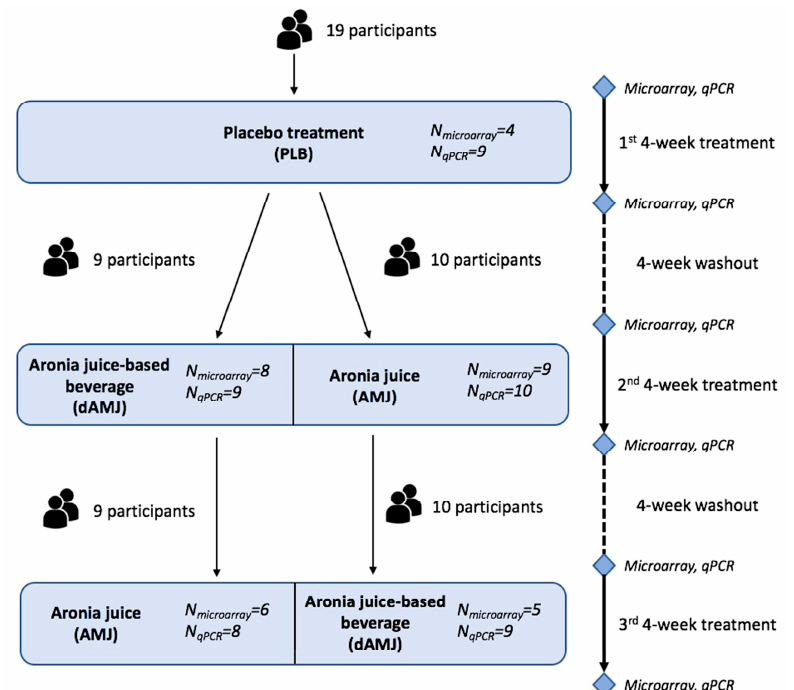
Figure 1. Study workflow. AMJ—treatment with original Aronia melanocarpa juice containing a total polyphenol amount of 11,771.09 mg gallic acid equivalent (GAE) / L, which corresponds to 1.17 g of total polyphenols per 100 mL of the allocated treatment (high dose); PLB—treatment with placebo beverage, a formulation that has the same appearance, taste, and nutritional composition of the original aronia juice, but without bioactive polyphenols; dAMJ—treatment with aronia juice-based beverage, made by diluting the AMJ with the PLB (ratio 1:3) and containing a total polyphenol amount of 2942.77 mg GAE / L, which corresponds to 0.29 g of total polyphenols per 100 mL of the allocated treatment (low dose).